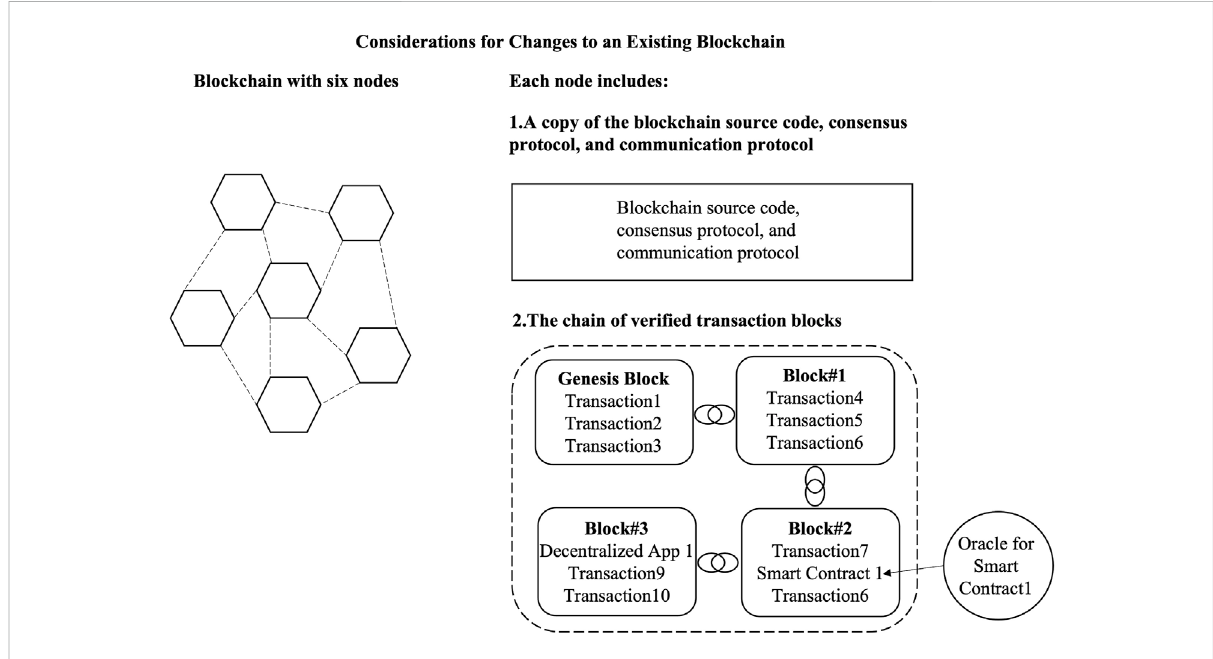
FIGURE 7 Considerations for changes to an existing blockchain (Sulkowski,